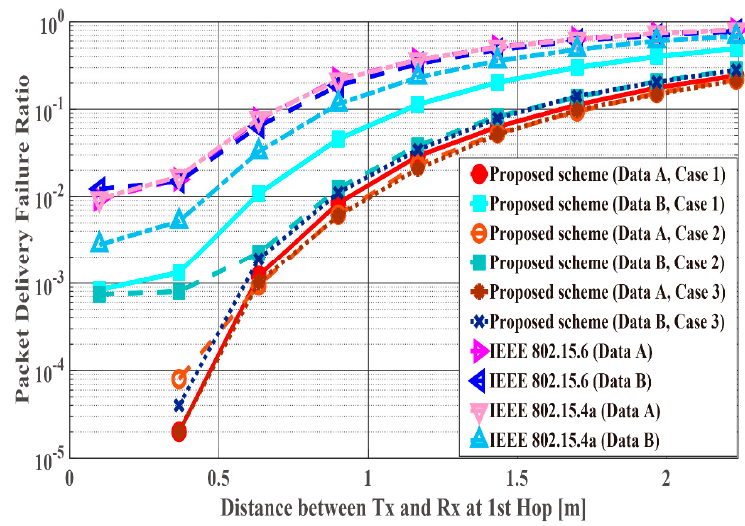
Figure 11. Packet delivery failure ratio with constant (cid:1856) (cid:2870)(cid:3041)(cid:3031) .